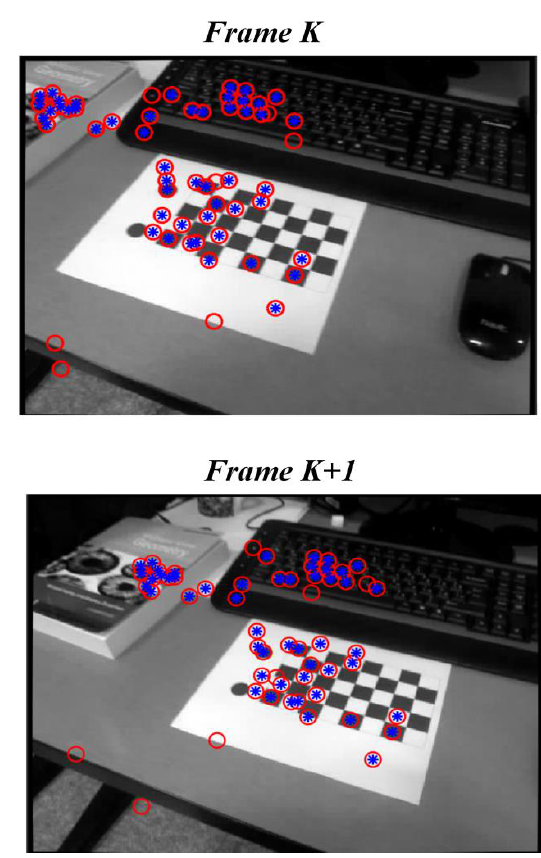
Figure 4. Feature points marked with empty red circles are output of feature matching routine, and those marked with blue asterisks surrounded in red circles are refined matchings based on RANSAC algorithm.